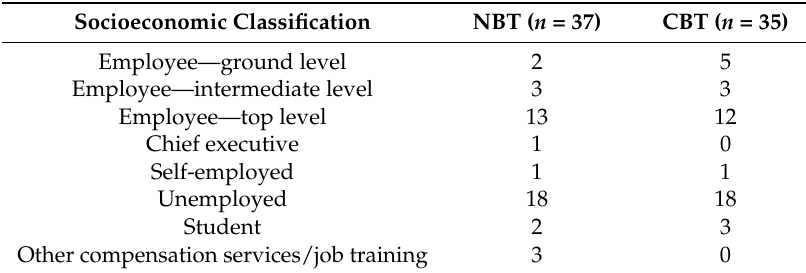
Table 1. Socioeconomic classification of